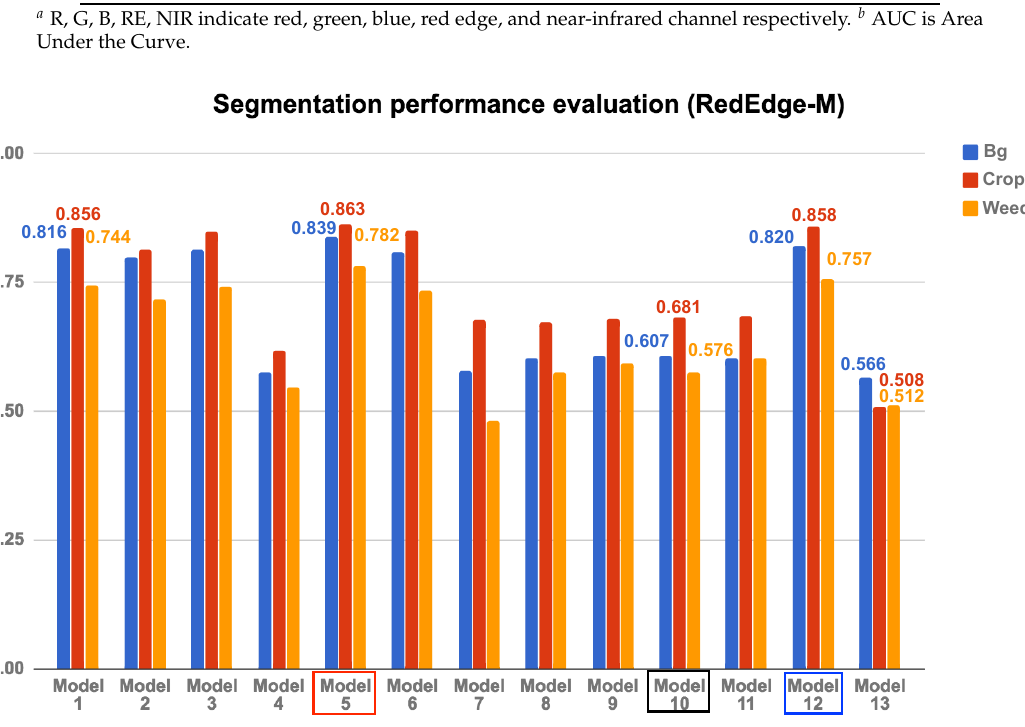
Figure 9. Quantitative evaluation of the segmentation using area under the curve (AUC) of the RedEdge-M dataset. The red box indicates the best model, the black one is our baseline model with only RGB image input, and the blue box is a model with only one NDVI image